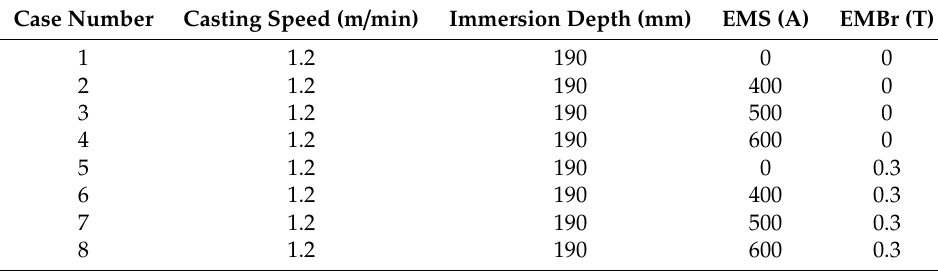
Table 2. List of the simulated